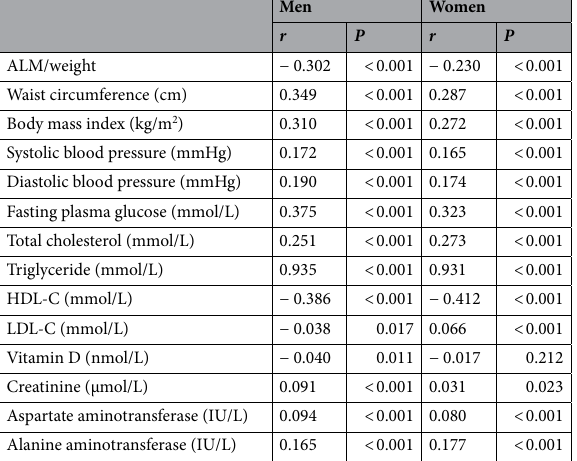
Table 3. Age-adjusted Spearman partial correlation analysis of the TyG index with clinical, metabolic, and body composition parameters. ALM appendicular lean mass; HDL-C high density lipoprotein cholesterol; LDL-C low density lipoprotein cholesterol.